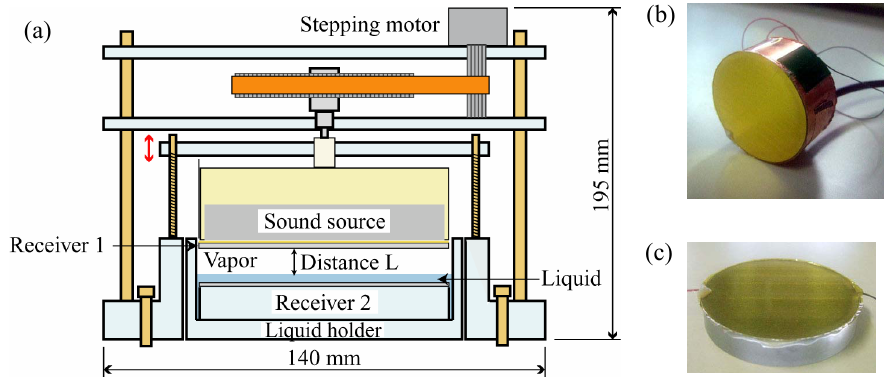
Fig.4 (a) Schematic of experimental setup, (b) Sound source and Receiver 1 and (c)